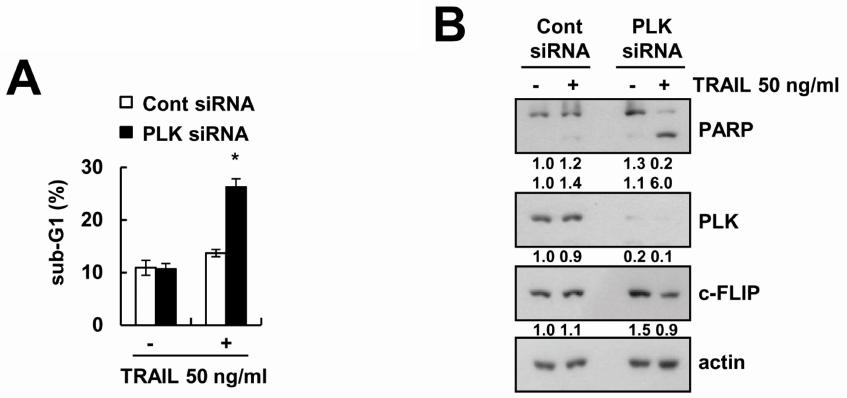
Figure 6. Downregulation of PLK by siRNA sensitizes TRAIL-induced apoptosis in Caki cells. ( A , B ) Caki cells were transiently transfected with control siRNA (Cont siRNA) or PLK siRNA. After transfection, Caki cells were treated with 50 ng/mL TRAIL for 24 h. The level of apoptosis was analyzed by the sub-G1 population using flow cytometry ( A ). The protein expression levels of PARP, PLK, c-FLIP, and actin were determined via Western blotting ( B ). The values in graph ( A ) represent the mean ± SD from three independent samples. * p < 0.01 compared to TRAIL-treated control